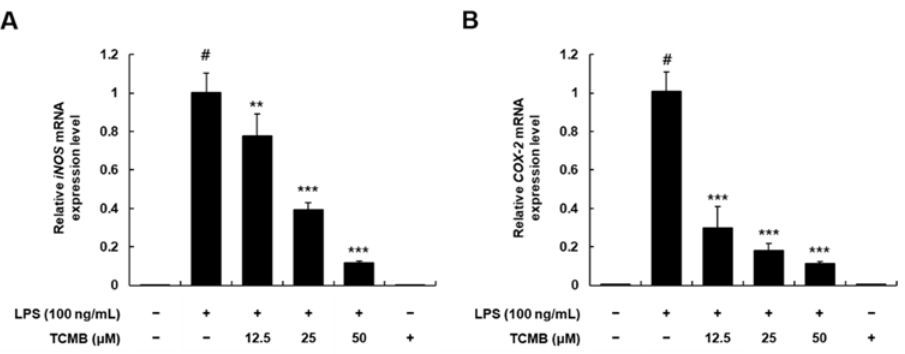
Figure 5. Effects of TCMB ( 11 ) on the mRNA expression levels of iNOS ( A ) and COX-2 ( B ) in LPS- stimulated RAW 264.7 macrophages. The cells were pretreated with compounds at concentrations of 12.5, 25, and 50 µ M for 6 h and then stimulated with LPS (100 ng/mL). Values are expressed as means ± SD. # p < 0.05 vs. non-LPS-induced control group; ** p < 0.01 and *** p < 0.001 as compared to the LPS only-induced